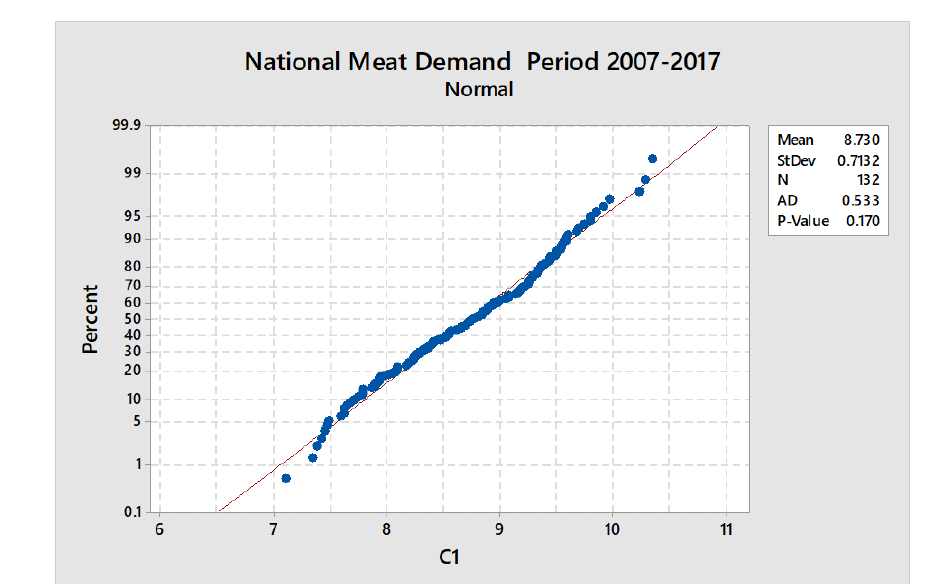
Fig. 5. National frozen meat demand with year period of 2007 – 2017